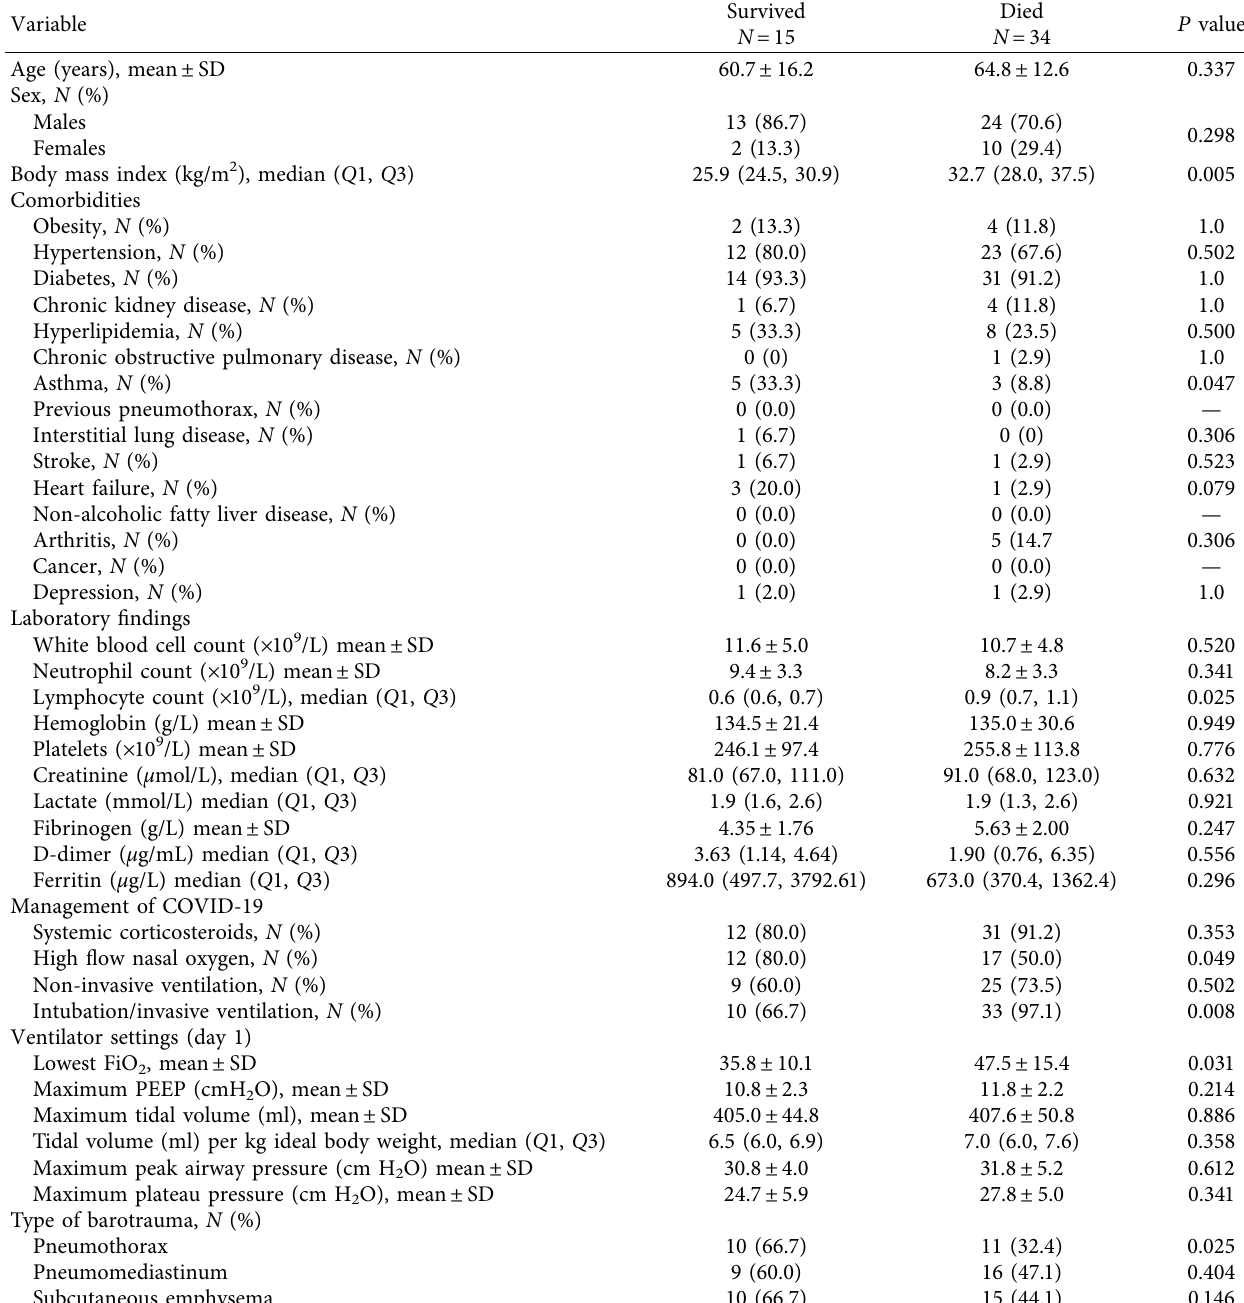
Table 5: Characteristics of the 49 patients with pulmonary barotrauma who survived to hospital discharge and died in the hospital. Variable